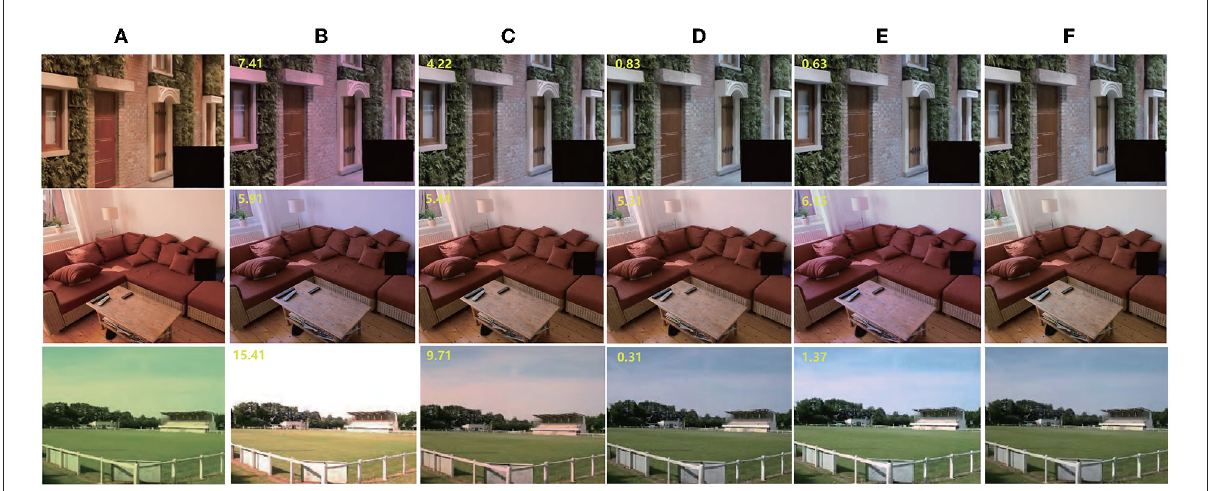
FIGURE7 Result of single illumination, the images come from ADE20k (Zhou et al., 2016). From left to right: (A) Original image; (B) Result by DS-Net (Shi et al., 2016); (C) Result by FC4 (Hu et al., 2017); (D) Result by MSRWNS (Wang et al., 2022); (E) Result by proposed method; (F) Ground truth. Dataset available at: https://groups.csail.mit.edu/vision/datasets/ADE20K/. Reproduced with permission from Zhou et al. (2016).